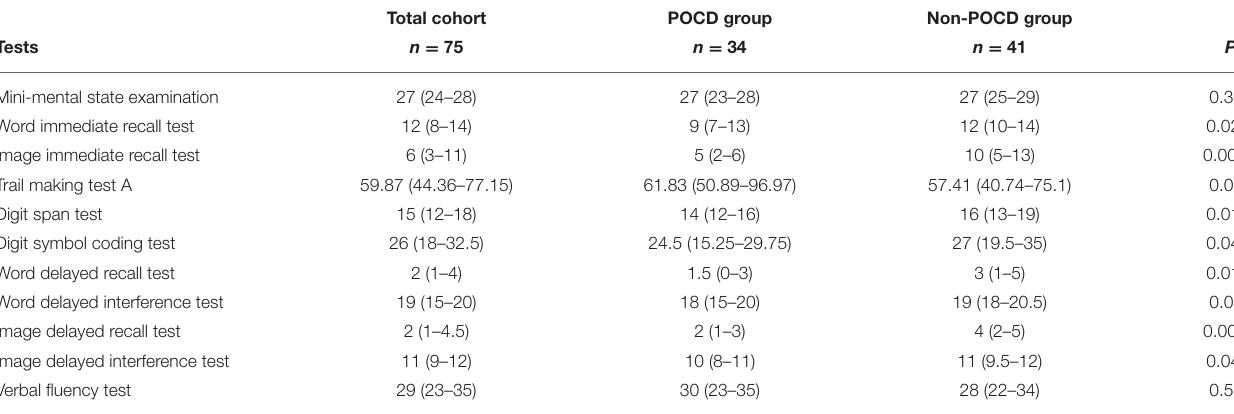
TABLE 3 | Postoperative cognitive functions of total cohort, POCD group, and non-POCD